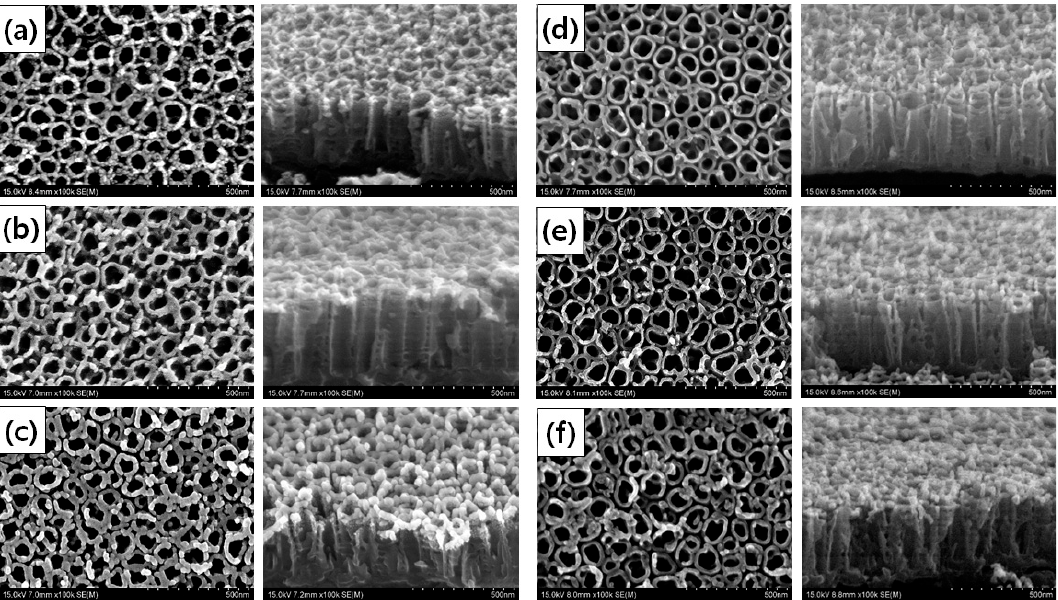
Figure 1. Field-emission scanning electron microscope (FE-SEM) images of 100 nm TiO 2 nanotubes after ( a ) 1 min, ( b ) 2 min, and ( c ) 3 min of gold sputtering; and ( d ) 1 min, ( e ) 2 min, and ( f ) 3 min of platinum sputtering (top: plain view, bottom: oblique view. Table 1. The diameter, height, and aspect ratio of Au and Pt nanoparticles deposited on TiO 2 nanotubes with various sputtering